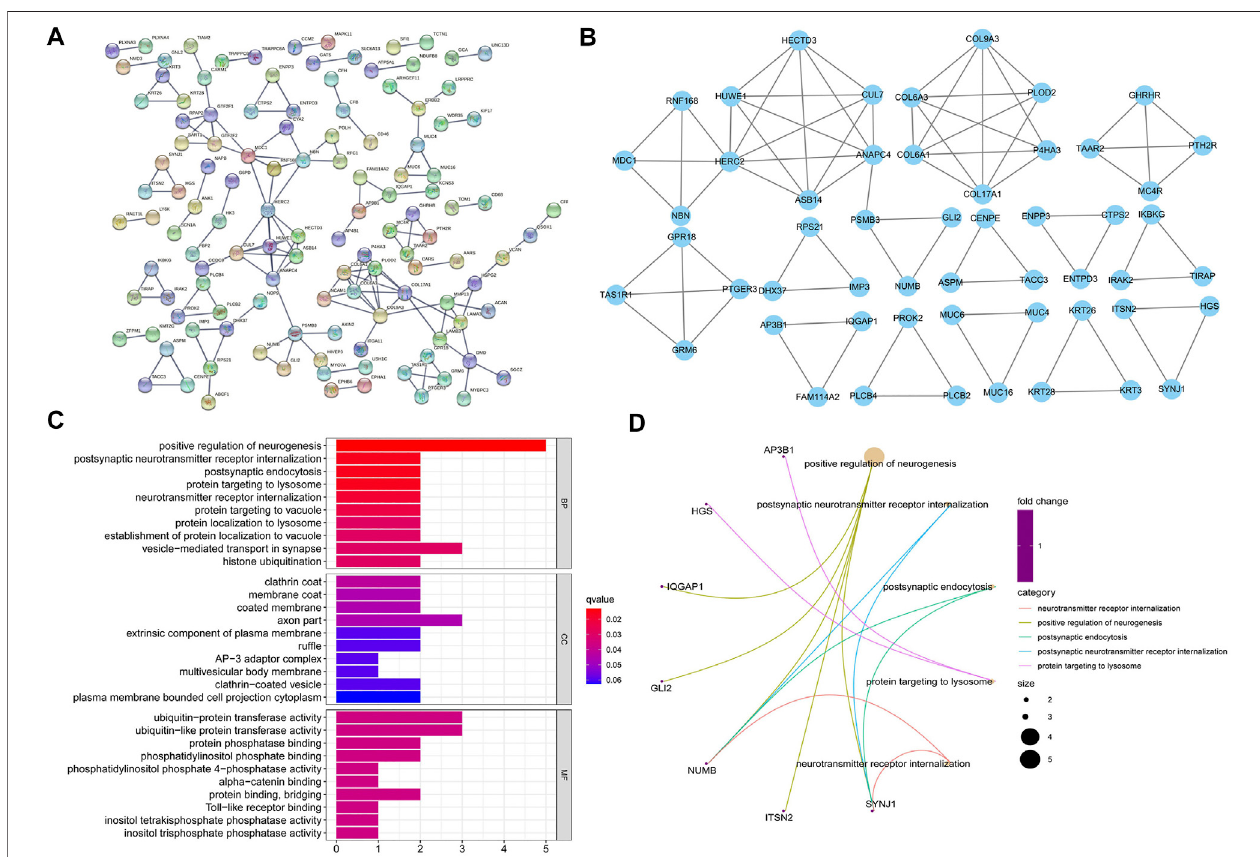
FIGURE 3 | Using the protein interaction network, we could determine a protein interaction relationship between different genes which participate in biological signaltransmission,geneexpressionregulation,andotherprocesses.Todeterminewhichgeneswereinthehubpositionintheregulatorynetwork,wescreenedthehub genesusingtheMolecularComplexDetection(MCODE)plug-in.Theobtainedhubgeneswerefurthersubjectedtoageneontology(GO)enrichmentanalysistoobserve thehubgenes ’ primaryenrichedfunctions. (A) Theprotein-proteininteractions(PPIs)ofmutatedsinglenucleotidepolymorphism(SNP)geneswereanalyzedusing the String database, and the criteria for construction were a combined score > 0.9. (B) The most signi fi cant module in the PPI network was obtained using the MCODE plug-in fortheCytoscape3.7.2onlinesoftware, and thecriteria wereobtained asfollows: degree cut-off (cid:2) 2,node scorecut-off (cid:2) 0.2, K-core (cid:2) 2,Maxdepth (cid:2) 100. (C/ D) GO function of the 53 hub genes is mainly enriched in these three parts: biological processes (BPs), molecular functions (MFs) and cellular components (CCs) ( p <